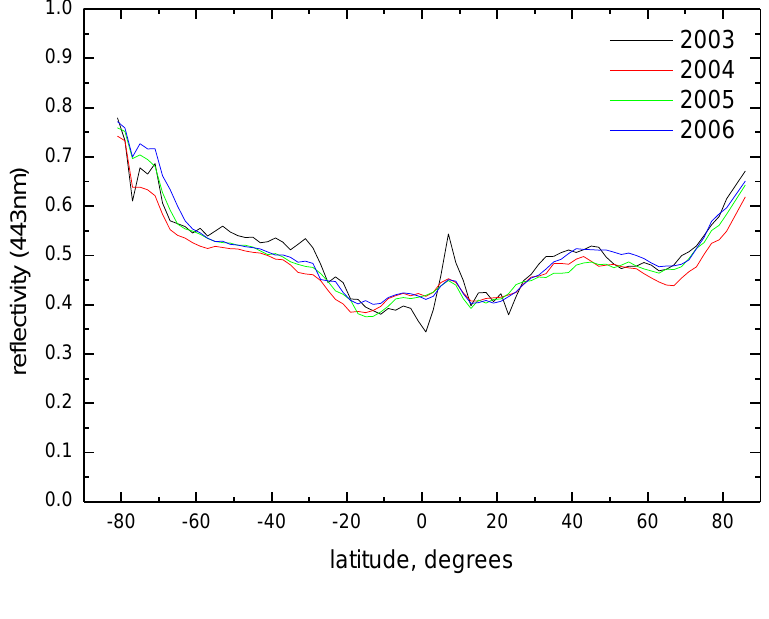
Figure 6. The latitudinal behavior of reflectivity (443 nm) for